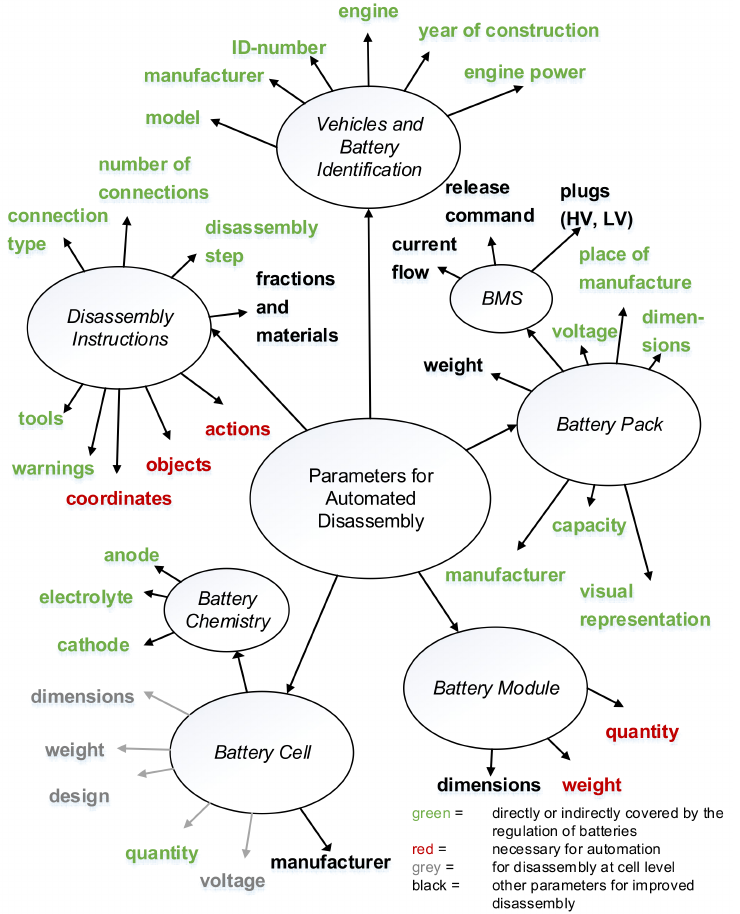
Figure 14. Parameters for an automated disassembly and an improved